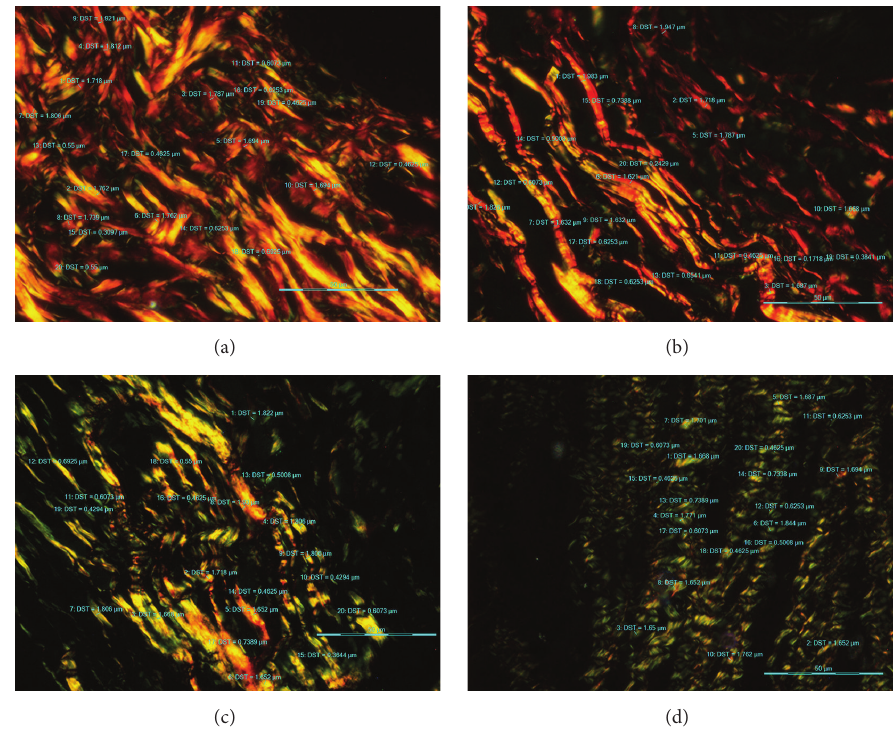
Figure 3: Photomicrograph of PSR stained sections under polarized light microscopy (40x). (a) NM showing predominantly thick YO collagen fibres. (b) WDSCC showing predominantly thick YO and thin GY collagen fibres. (c) MDSCC showing thick YO and thick GY collagen fibres. (d) PDSCC showing thick GY and thin GY collagen